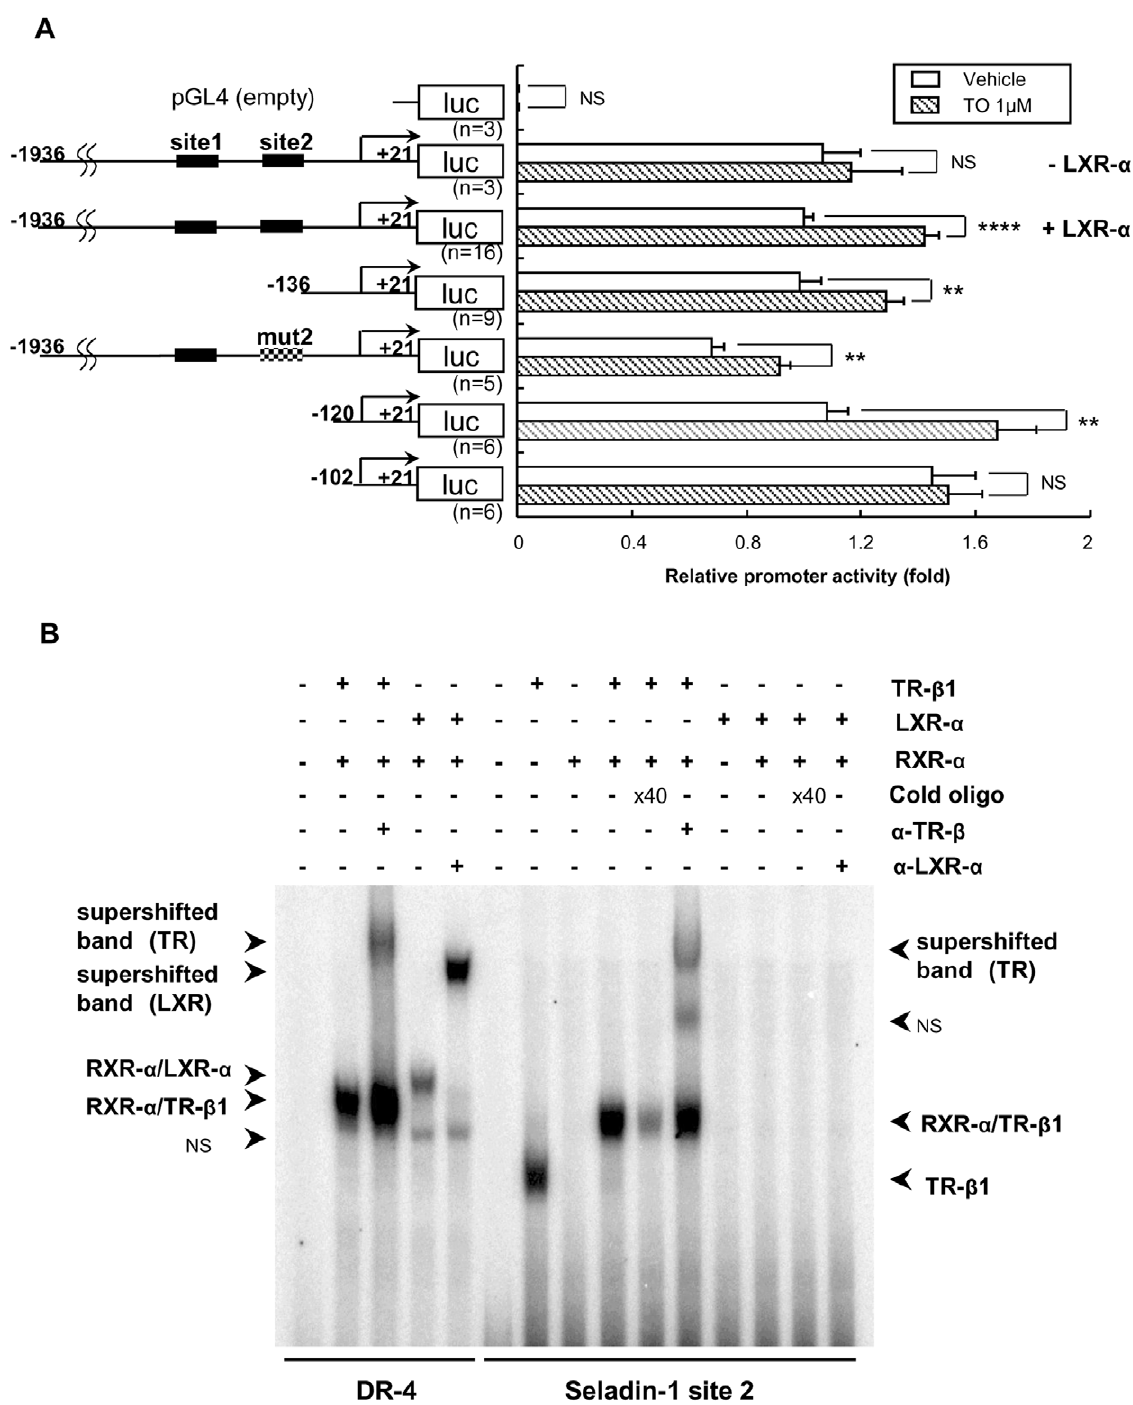
Figure 7. TO induced the mouse Seladin-1 gene promoter activity but LXR- a did not bind to site 2. A) A schematic representation of the deletion mutants and site 2 mutant (mut 2) of the mouse Seladin-1 gene promoter. The closed boxes indicate site 1 and 2. The hatched box indicates mutation in the TRE half-site. TO induced the mouse Seladin-1 gene promoter ( 2 1936/ + 21 bp) coupled to the luciferase reporter construct (pGL4) in CV-1 cells in the presence of LXR- a . Vehicle for TO was DMSO. Relative luciferase activities (mean 6 S.E.) compared with the light units of the wild mouse Seladin-1 promoter ( 2 1936/ + 21 bp) reporter with LXR- a in the absence of TO (arbitrary light units divided by cellular protein and by b -gal activity) are shown as relative promoter activity (fold). The number of samples is indicated in the figure. An asterisk indicates that the difference between the denoted pairs is significant at a confidence level of p , 0.01(**) and p , 0.0001(****). NS: not significant. B) LXR- a or RXR- a /LXR- a does not bind to site 2. Six microliters (indicated as ‘ + ’) of in vitro -translated human TR- b 1 and/or human RXR- a and/or mouse LXR- a protein were incubated with 32 P-radiolabeled DNA probes. For competition experiments, 40-fold molar excess of cold oligonucleotides was included as indicated. NS: Non- specific band. a -TR- b : rabbit anti-TR- b antibody. a -LXR- a : mouse anti-LXR- a antibody. DR-4: Direct repeat-4.